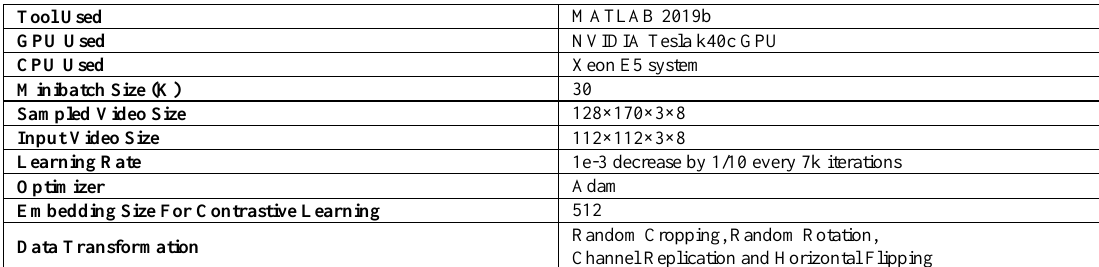
Table 3. Implementation